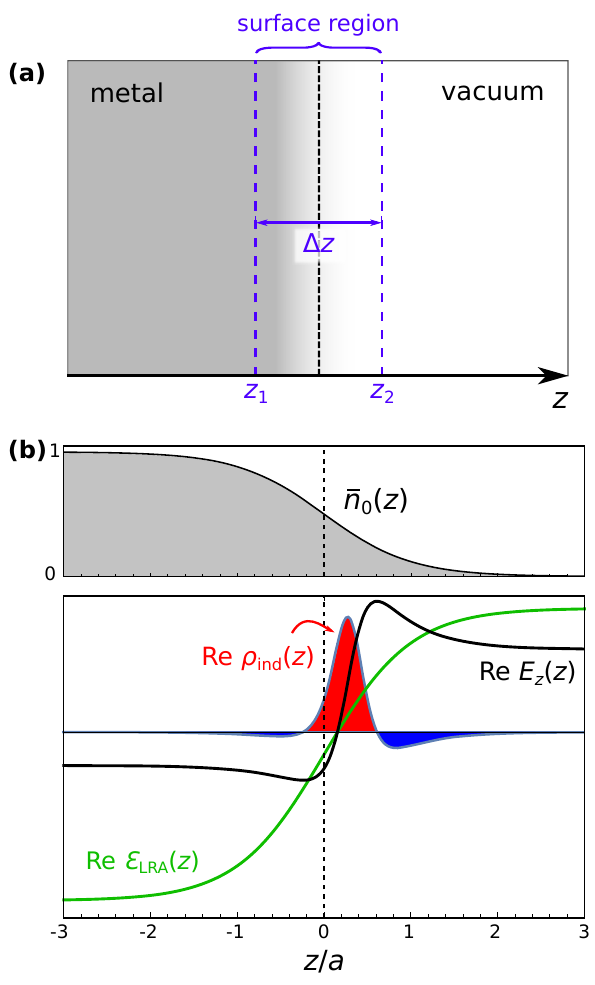
Figure 1: Schematic representation of the microscopic features of a metal–vacuum interface. (a) Metal–vacuum interface, indicating the surface region where the electron density varies from its asymptotic, ≡ 𝜀 ≡ 𝜀 ( z < z ) and 𝜀 ( z > z ) = 1 (where bulk values 𝜀 m LRA 1 d LRA 2 | ≫ 0). (b) Top: schematic of the (normalized) equilibrium | z 1 , 2 ( z ) characterized by a smearing length a electron-density profile ̄ n 0 in the vicinity of the surface (here defined by the z = 0 plane). ( z ) Bottom: Real part of the system’s dielectric function Re 𝜀 LRA [Eq. (8)] associated with ̄ n ( z ) = [ 1 − tanh( z ∕ a ) ]∕ 2, along with the 0 ∝ 𝜕 𝜀 − 1 ( z ) and Re 𝜌 ( z ) [note that 𝜌 in the ensuing Re E ind ind z z LRA long-wavelength regime]. All quantities are in arbitrary units. √ ∕ 3, and for visualization purposes a Parameters: 𝜔 = 𝜔 p = 0 . Drude-type bulk damping of 𝛾 ∕ 𝜔 p